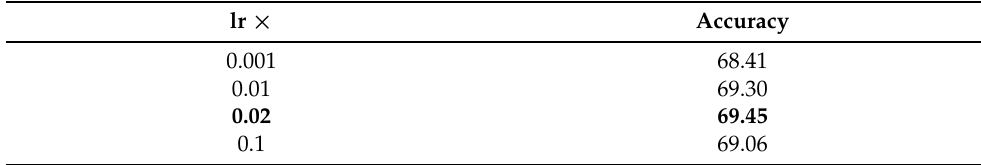
Table 4. Validation scores on VQA2.0 dataset for the BERT’s learning